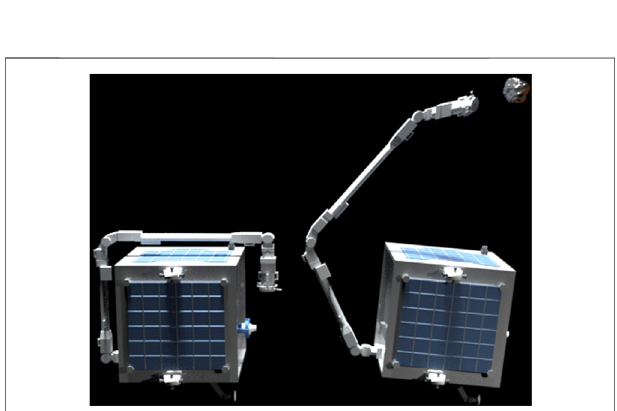
FIGURE 1 | Schematic diagram of a spacecraft-manipulator arm.